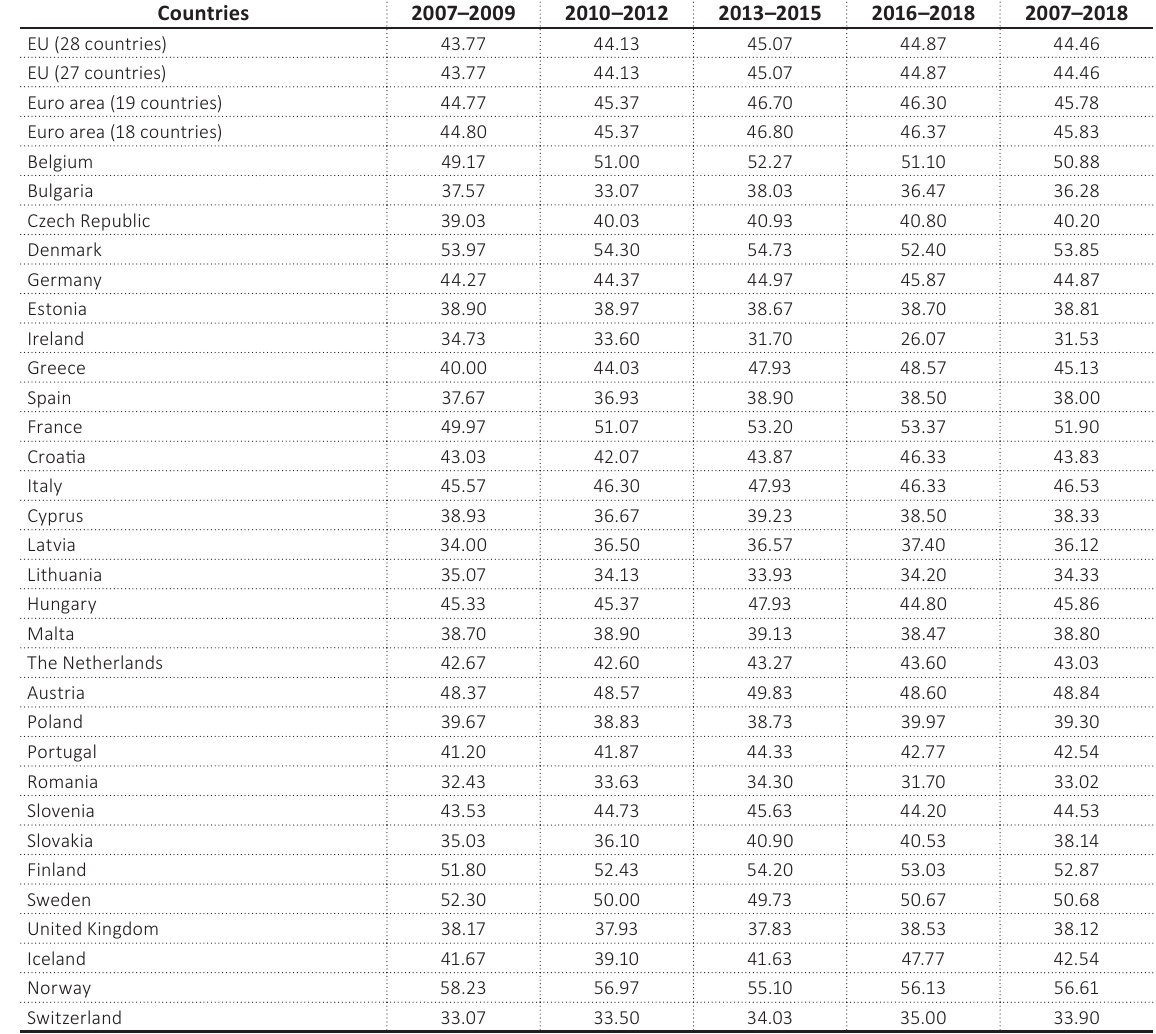
Table 1. Share of general government revenue of the EU countries in GDP, % Source: Based on the data from Official site of the Statistical Office of the European